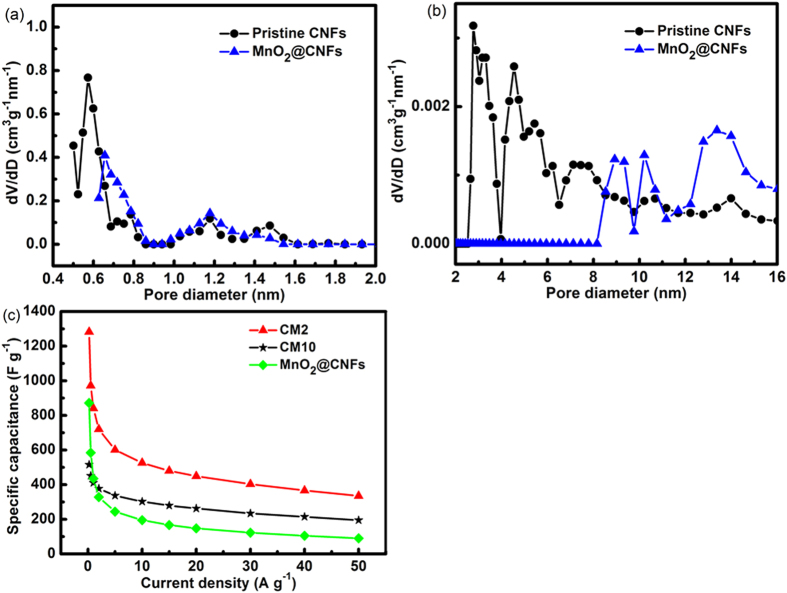
(a,b) Pore-size distributions of the pristine CNFs and ones loaded with MnO2 under the same conditions as MC2 composites, (c) dependences of specific capacitance on current density for MnO2/PVP induced porous CNFs and MnO2/PVP free CNFs electrodes.